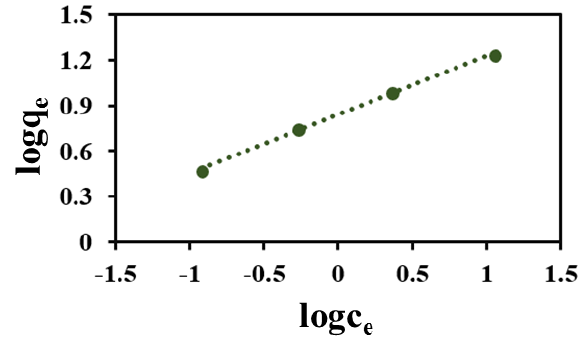
Figure 13. Freundlich isotherms for the adsorption of NOR by MNPC at 30 °C.